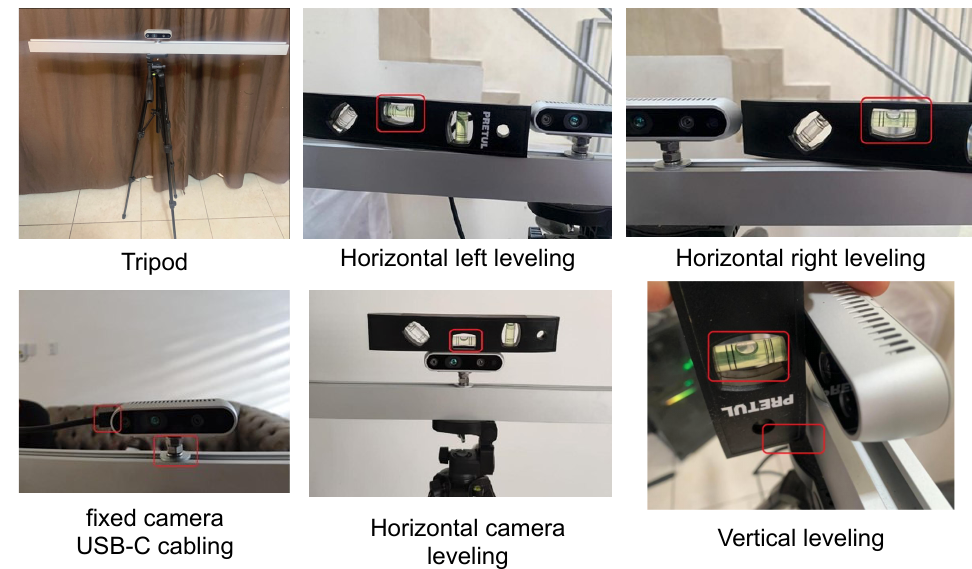
Figure 6. An example of adjusting and leveling the RGB-D camera.